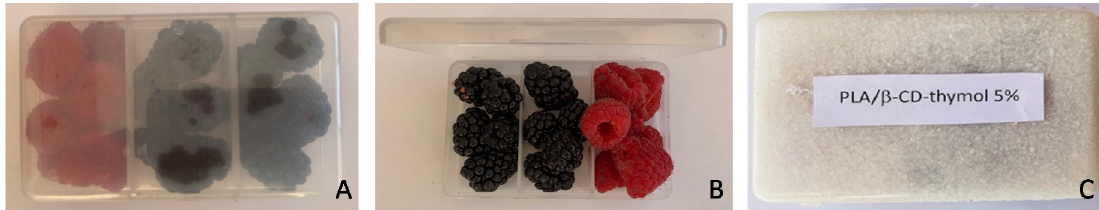
Figure 1. Boxed samples containing blackberries and raspberries. ( A ) PLA/C, closed; ( B ) PLA/ β -CD-carvacrol, 2.5% wt%, open; ( C ) PLA/ β -CD-thymol, 5.0% wt%, closed.